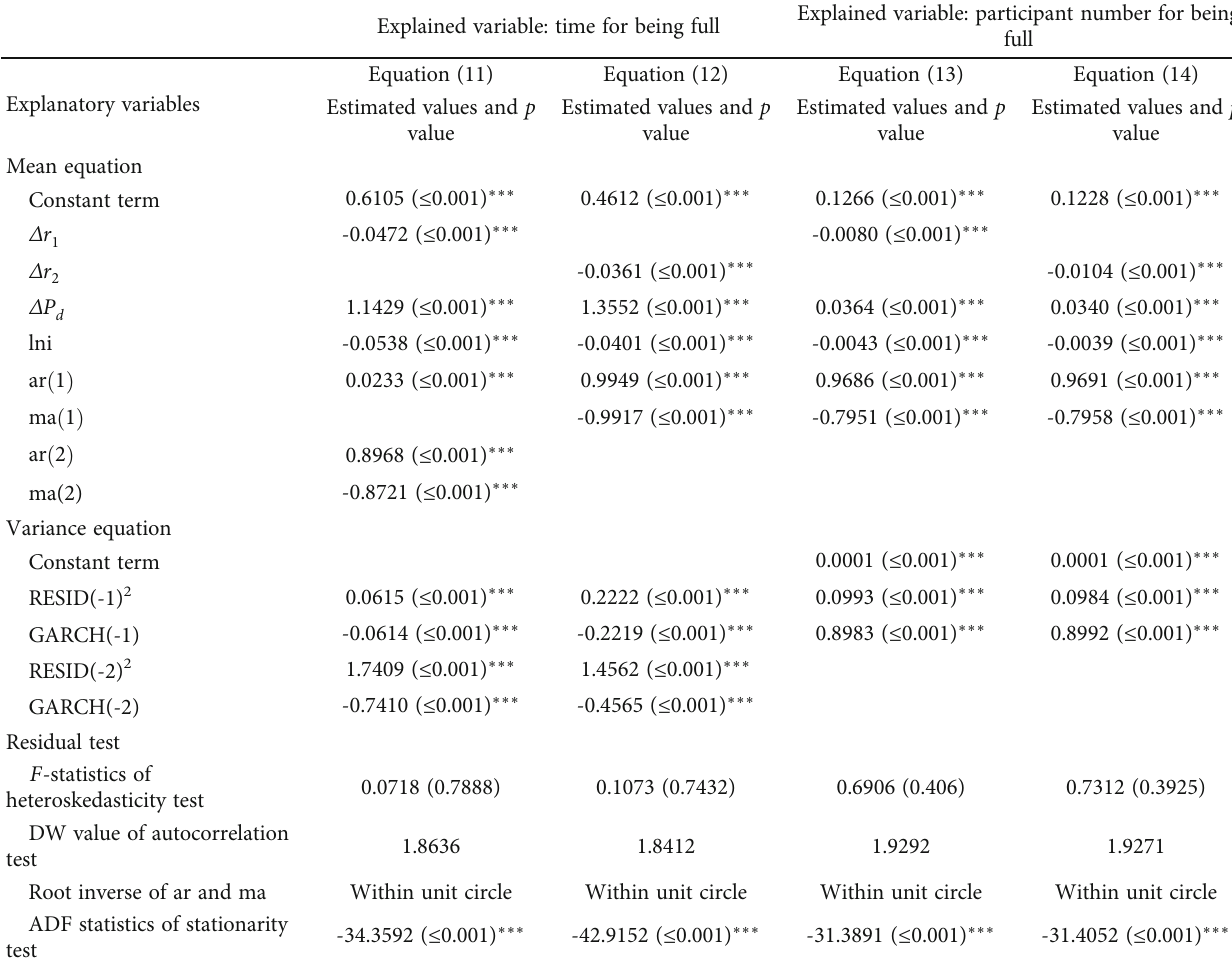
Table 8: Regression results to time and participant number for being full. Explained variable: time for being